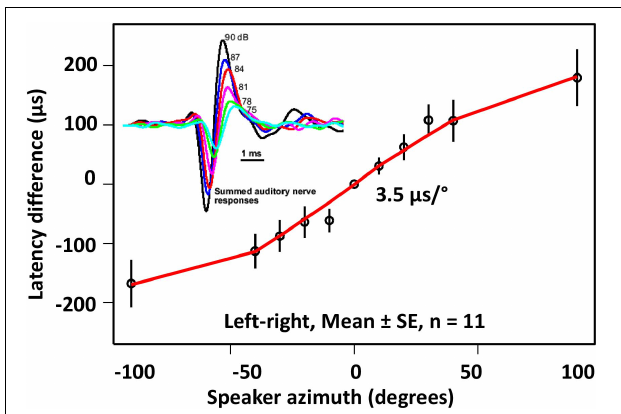
FIGURE 2 | Interaural latency differences as a function of sound source azimuth [redrawn from Mason et al. (2001)]. Inset: Summed auditory nerve responses recorded for different sound levels. Using sound level as a proxy for directional variation in relative tympanal vibration amplitude, these data show that in addition to the nITDs represented in the main plot, contralateral neural responses are weaker for a directional sound